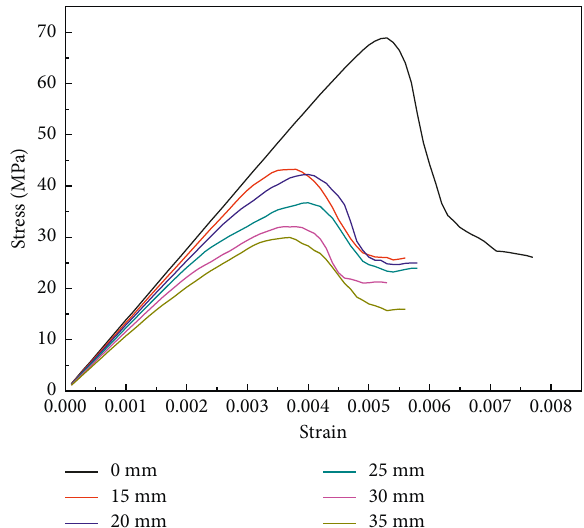
Figure 13: Stress-strain curves of uniaxial compression tests with different lengths of preexisting